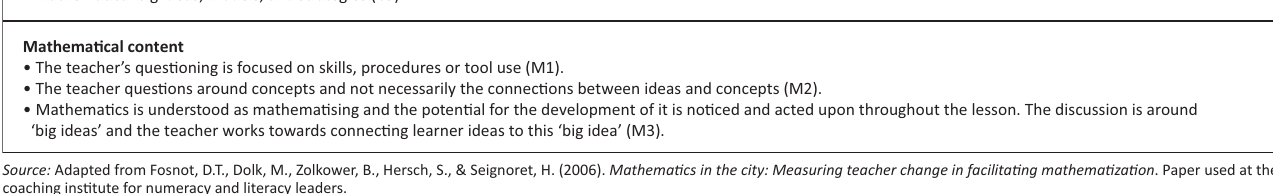
FIGURE 4: Classroom observation rubric.